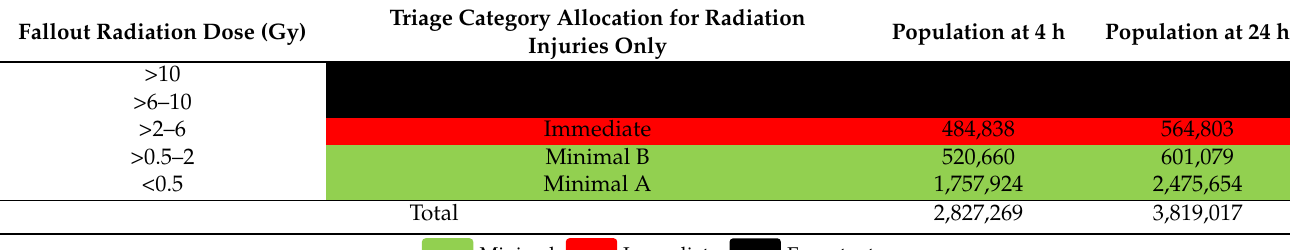
Table 5. Human casualties from fallout radiation only (1 × 25 kt nuclear weapon).